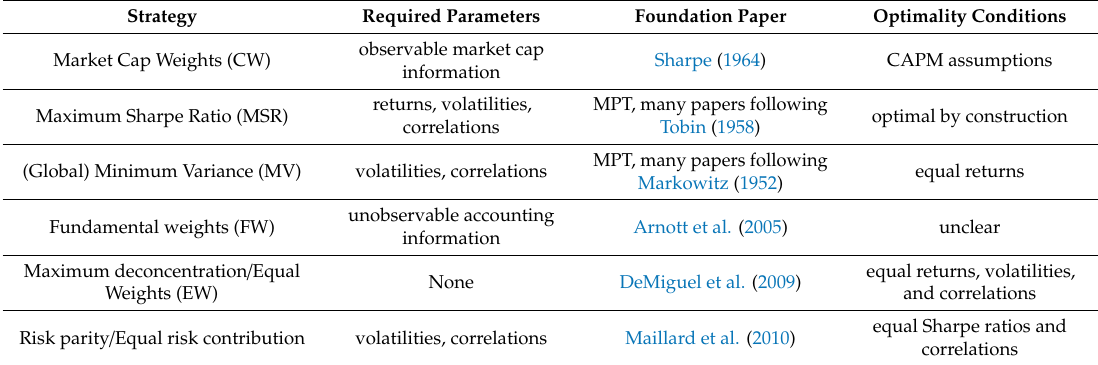
Table 1. Overview of diversification strategies regarding unrewarded risk factors. Reproduced